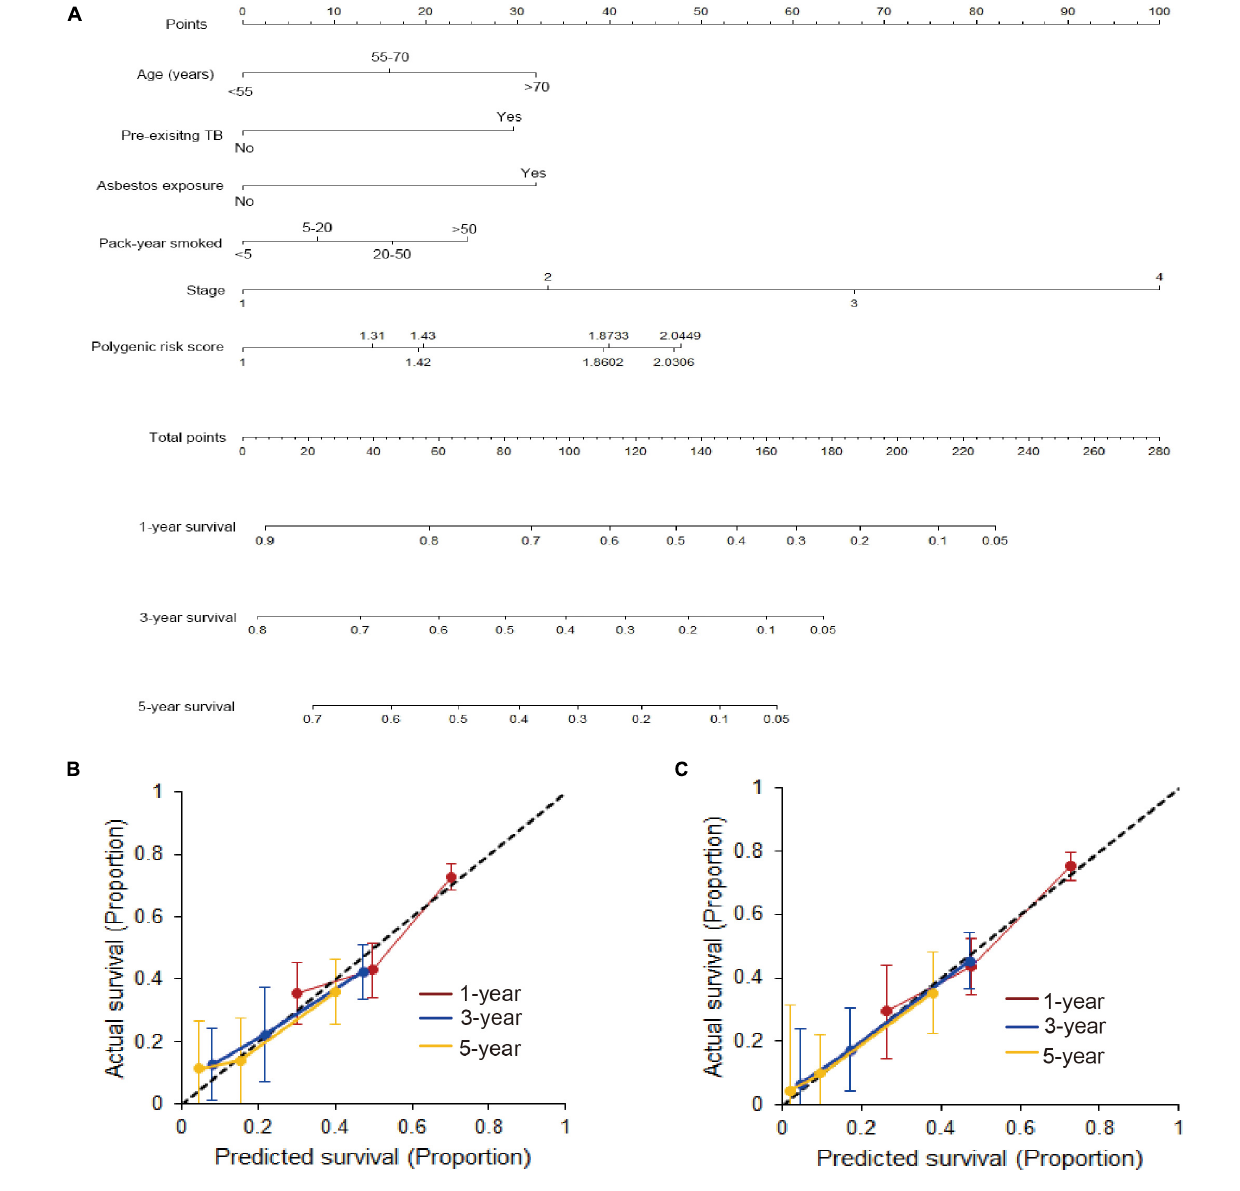
FIGURE 3 | Developed nomogram based on gCNVs and surrounding factors. (A) A nomogram was developed in the training cohort with PRS, age, pre-existing TB, asbestos exposure, pack-year smoked and stages incorporated. (B) Calibration curve of the nomogram in the training cohort. (C) Calibration curve of the nomogram in the validation